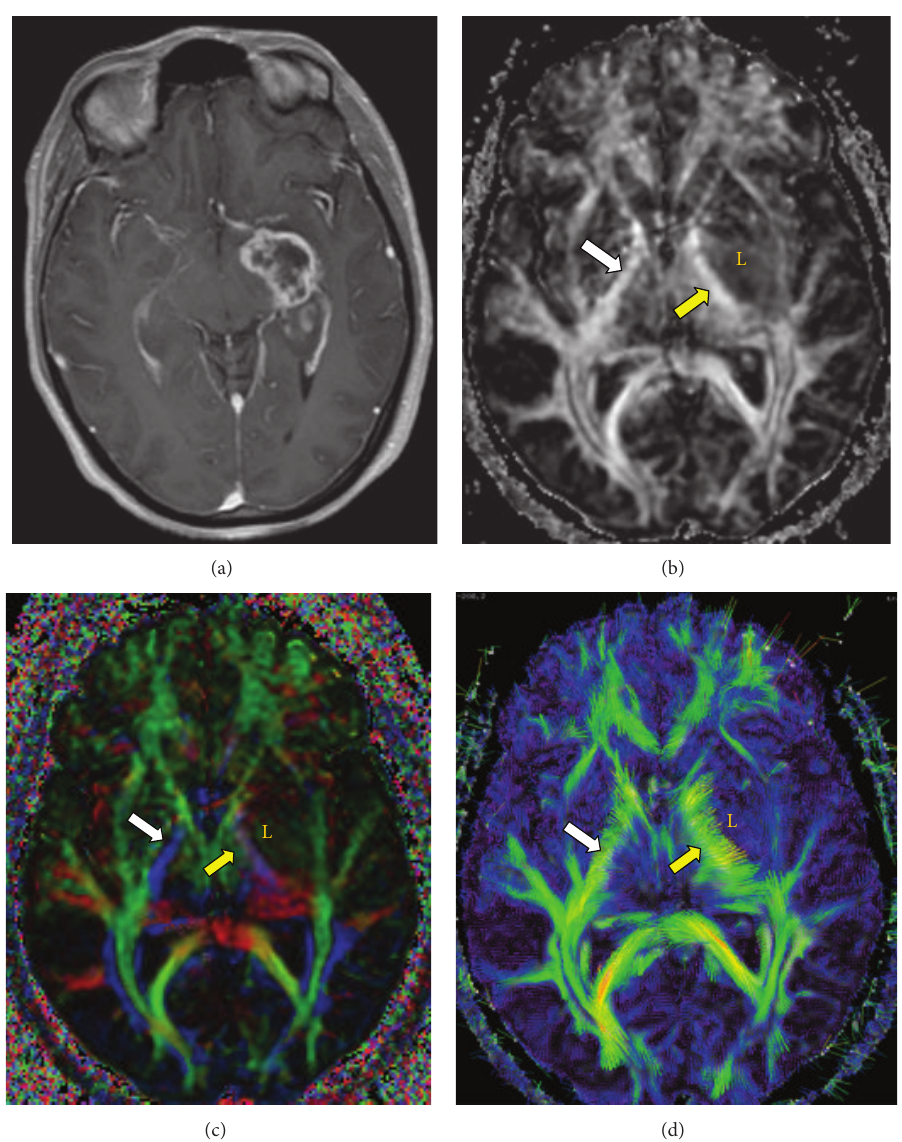
Figure 6: A 47-year-old female with left temporal glioblastoma multiform (L). (Case 3): (a) axial T1 postgadolinium; (b) grayscale FA (GSFA) map; (c) color coded orientation map (CCOM); and (d) nonstereoscopic 𝑉 max view. The question is the left corticospinal tract (CST) (yellow arrow) affected by the lesion or not? The CCOM suggested that the CST was affected by the lesion evidenced by change in its blue color (i.e., fibers have changed their direction), as well as the intensity of the blue color (i.e., fibers have changed their FA value); so conclusion was the CST is infiltrated by the lesion. The 𝑉 max images suggest that the ipsilateral CST is almost normal, apart from being slightly displaced, and having a higher FA values compared to opposite side (more yellow areas); so the conclusion was that the fibers are only displaced. The higher FA value could reflect the fibers becoming more compact as a result of the mass effect. To resolve this discrepancy, we resorted to the GSFA images as well as the clinical data. The GSFA showed that both CST have almost the same intensity (i.e., FA values) (white arrow = normal CST), so our conclusion was that the fibers are most likely not infiltrated. A through clinical exam revealed that there is no motor